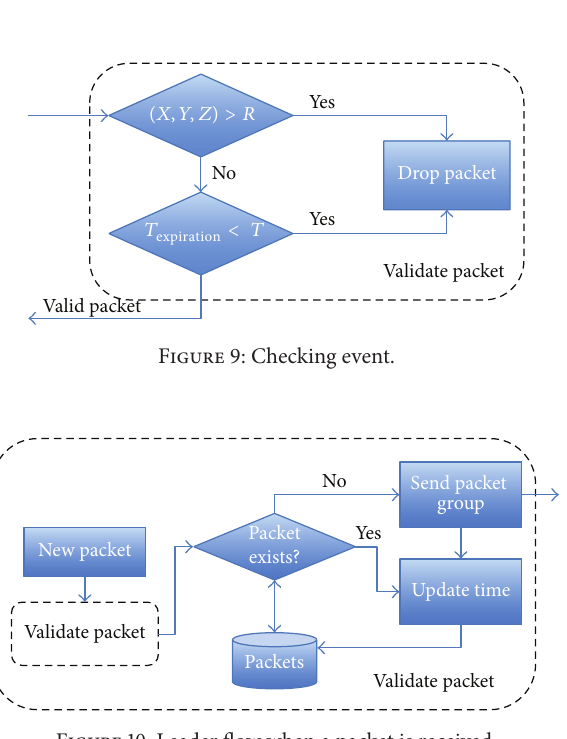
Figure 8: Event generation and action range.